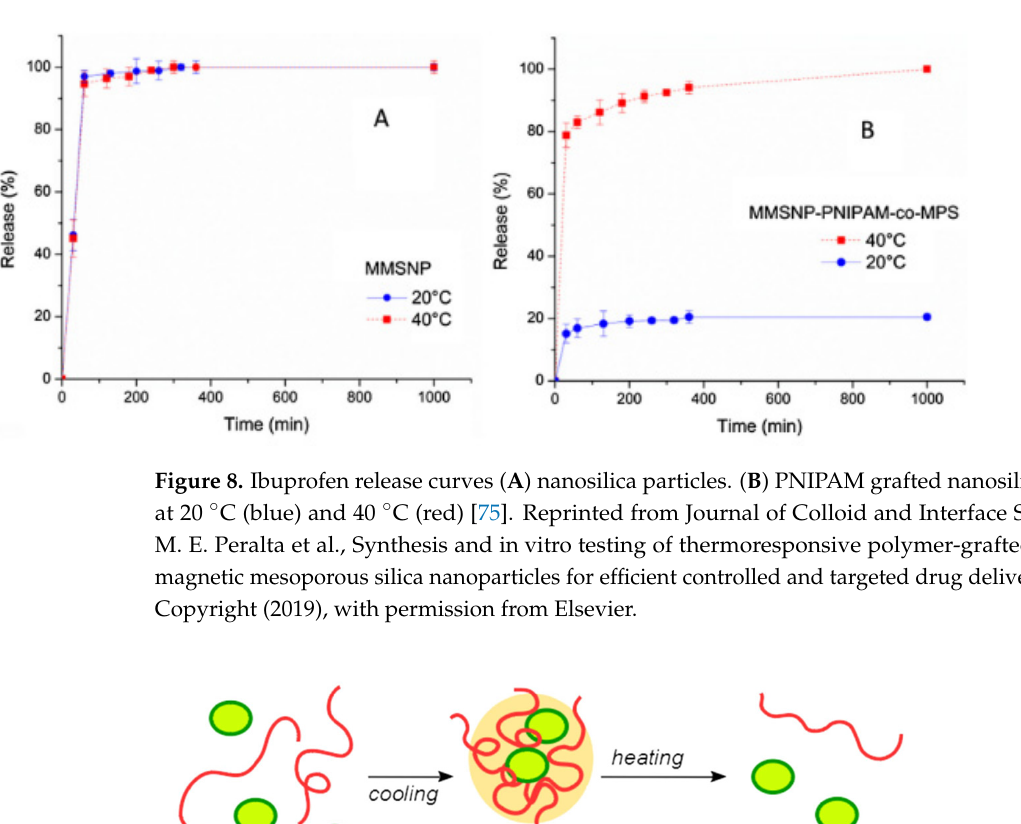
Figure 8. Ibuprofen release curves ( A ) nanosilica particles. ( B ) PNIPAM grafted nanosilica particles at 20 °C (blue) and 40 °C (red) [75]. Reprinted from Journal of Colloid and Interface Science, 544, M.